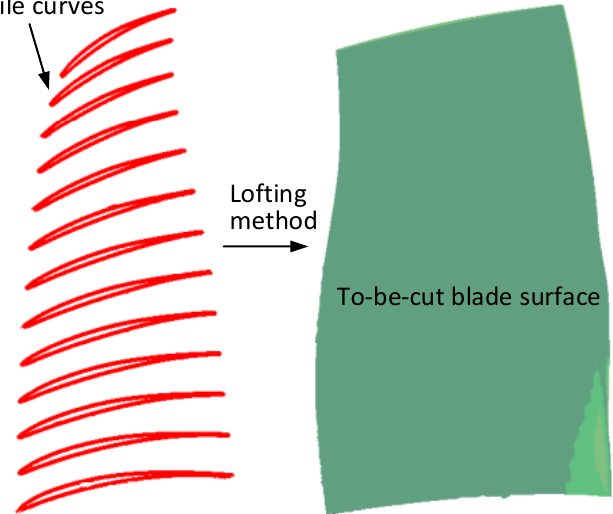
Figure 5. The to-be-cut blade surface is reconstructed by the localized profile curves C i ( v )